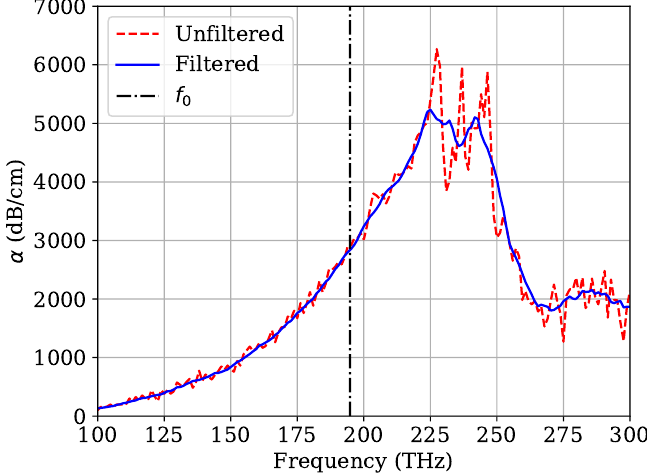
Figure 6. α vs. frequency, for a rough waveguide ( σ = 15 nm, L c = 200 nm) with noisy FDTD data (red dashed line) compared to filtered FDTD data (blue solid line), where f 0 is the excitation source